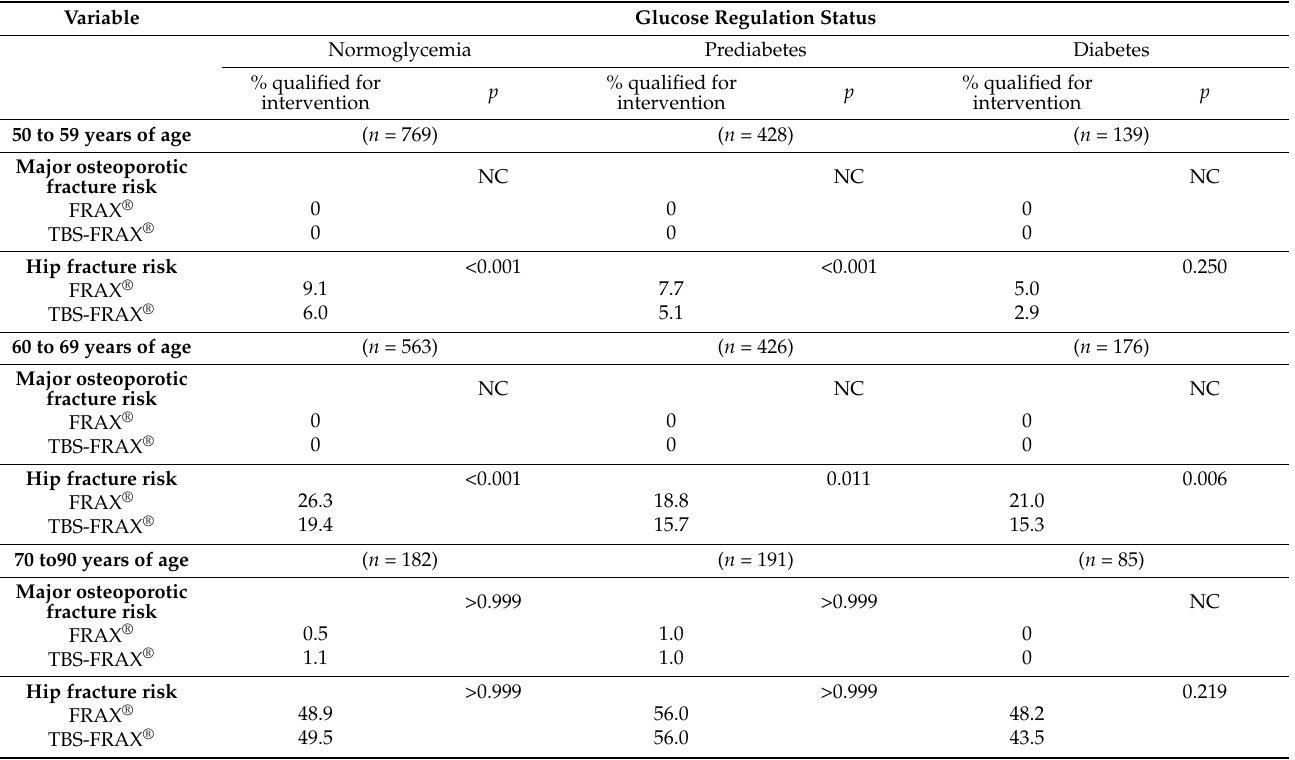
Table 3. The proportions of men in different age groups at high risk of major osteoporotic fracture ( ≥ 20%) and hip fracture ( ≥ 3%) according to the FRAX ® and TBS-FRAX ® , with stratification by glucose regulation status.